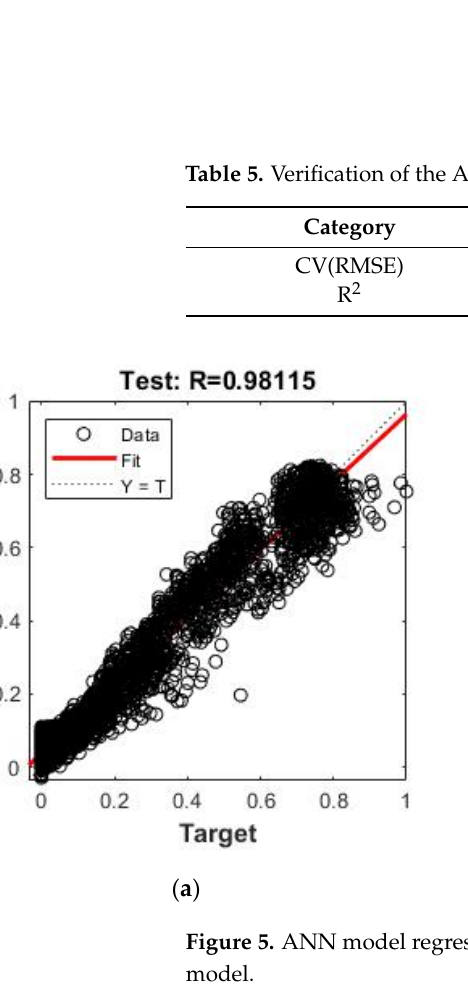
Figure 6. Hourly mixed-air temperature set point and cooling energy consumption. 2.